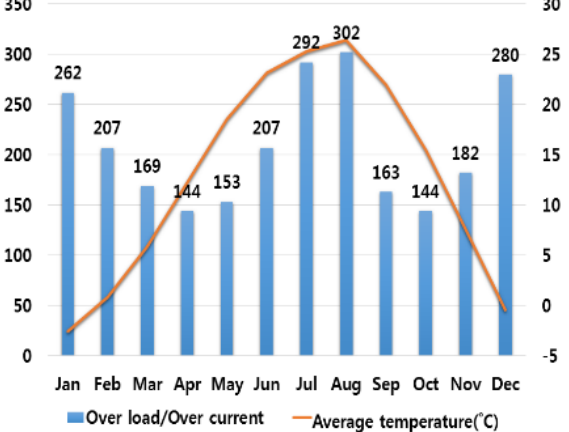
Figure 3. Correlation between the number of fires caused by overload/over current and the average temperature on a monthly basis.